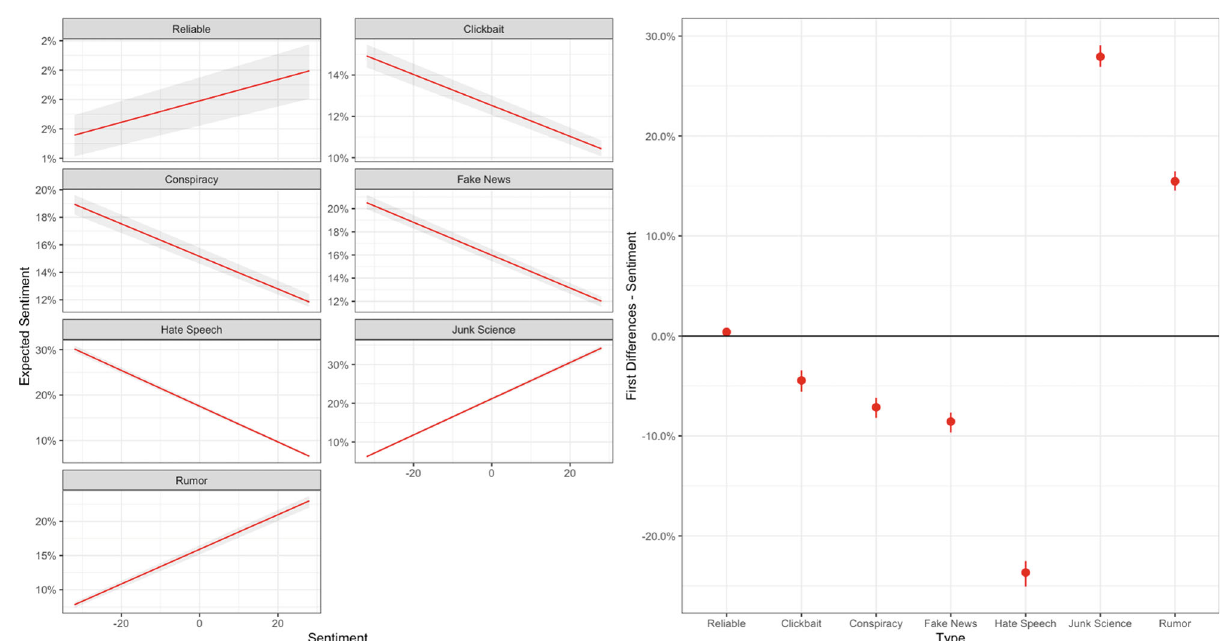
Fig. 7 First differences of the multinominal logit model −